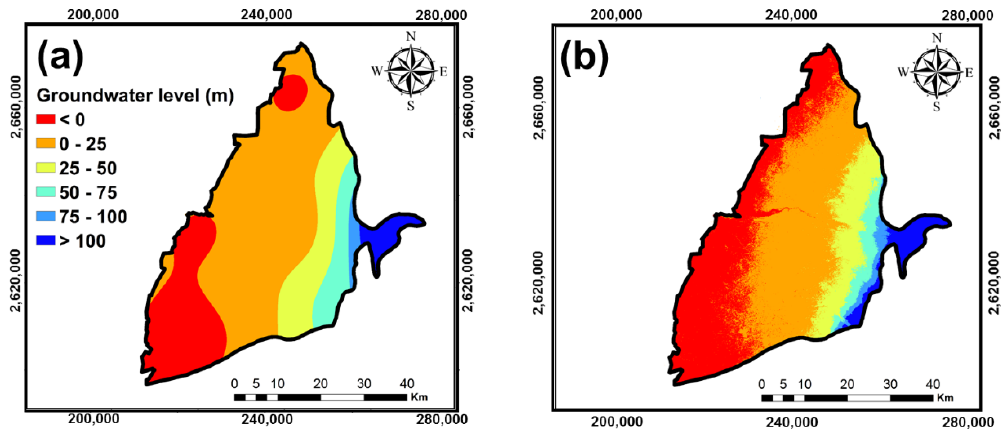
Figure 4. The comparison of the GWL based on two different geostatistical interpolation methods: ( a ) the map of GWL using Ordinary Kriging (OK) for January 2006; ( b ) the map of GWL using Regression Kriging (RK) for January 2006. Note that the land surface elevation has been considered in the RK for the additional variable.